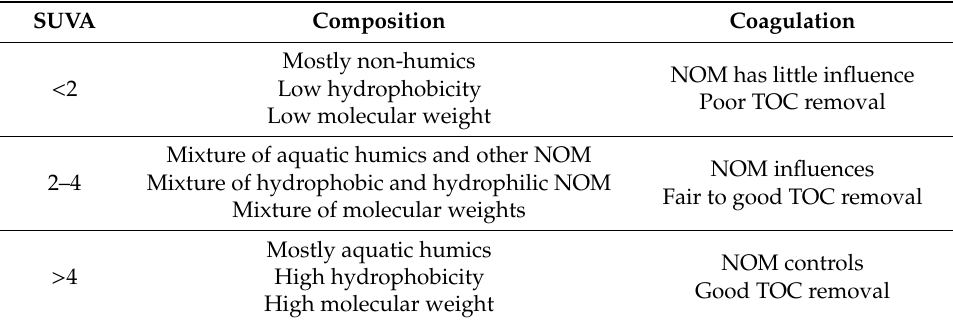
Table 3. Guidelines on the nature of NOM and expected TOC removals.